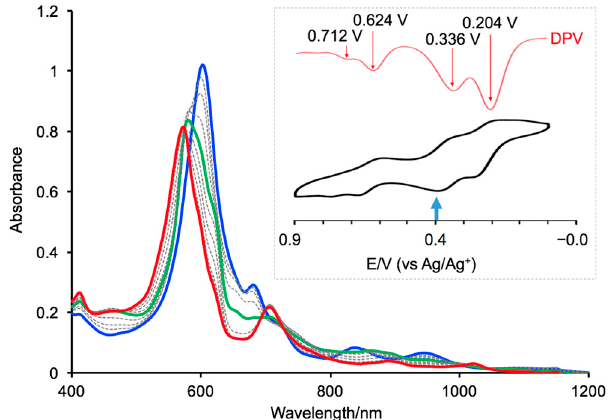
Figure 5. Absorption spectral changes of a CH 2 Cl 2 solution of [28]Hex containing 0.1 M nBu 4 NPF 6 , upon the electrochemical oxidation (set with 0.4 V): The absorption spectral changes were monitored with linear sweep voltammetry set in 0.4 V for the initial and final potentials (working electrode: Pt mesh, counter electrode: Pt, reference cell: Ag / AgCl 4 ). Inner graph represents oxidation potentials of [28]Hex; the graph in black is for cyclic voltammogram (scan rate = 0.2 V / s) and the graph in red is for differential pulse voltammogram, respectively (working electrode: Pt, counter electrode: Pt, reference cell: Ag / AgCl 4 ).